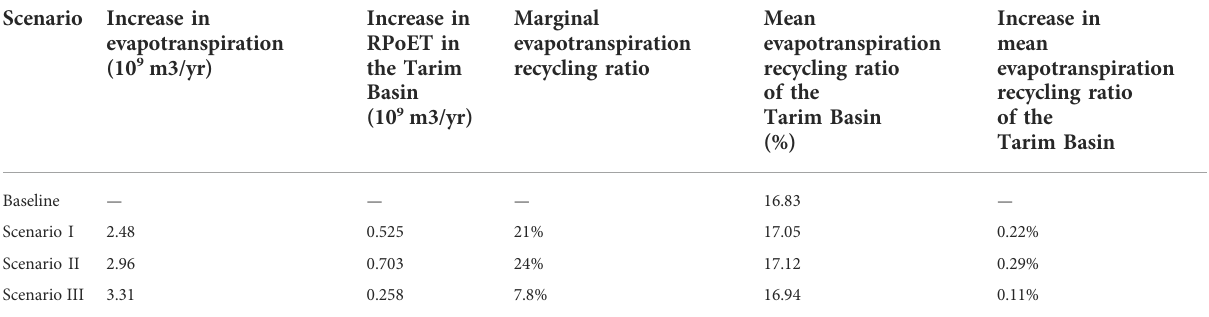
TABLE 2 Change in moisture recycling under different